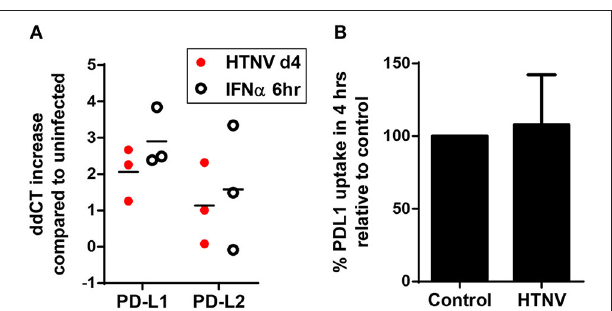
FIGURE 4 | Increase in PD-L1 and PD-L2 transcripts but not cellular uptake in hantavirus-infected immature DCs. (A) Immature DCs were infected with HTNV at MOI of 1.5 and incubated for 4 days or exposed to IFN- α for 6h at 2,000 U/ml before being harvested. Subsequently, RNA was isolated and the number of indicated transcripts quantified by qPCR according to the delta-delta-Ct (ddCt) method. (B) Immature DCs infected as for (A) were incubated with PE-coupled anti-PD-L1 antibody at 4 ◦ C 1h or at 37 ◦ C for 4h before being washed and analyzed by flow cytometry. Uptake was calculated by subtracting MFI at 37 ◦ C from MFI at 4 ◦ C. Uptake of HTNV infected cells was then compared to uninfected cells. Results are derived from three independent experiments, error bars represent the mean ±